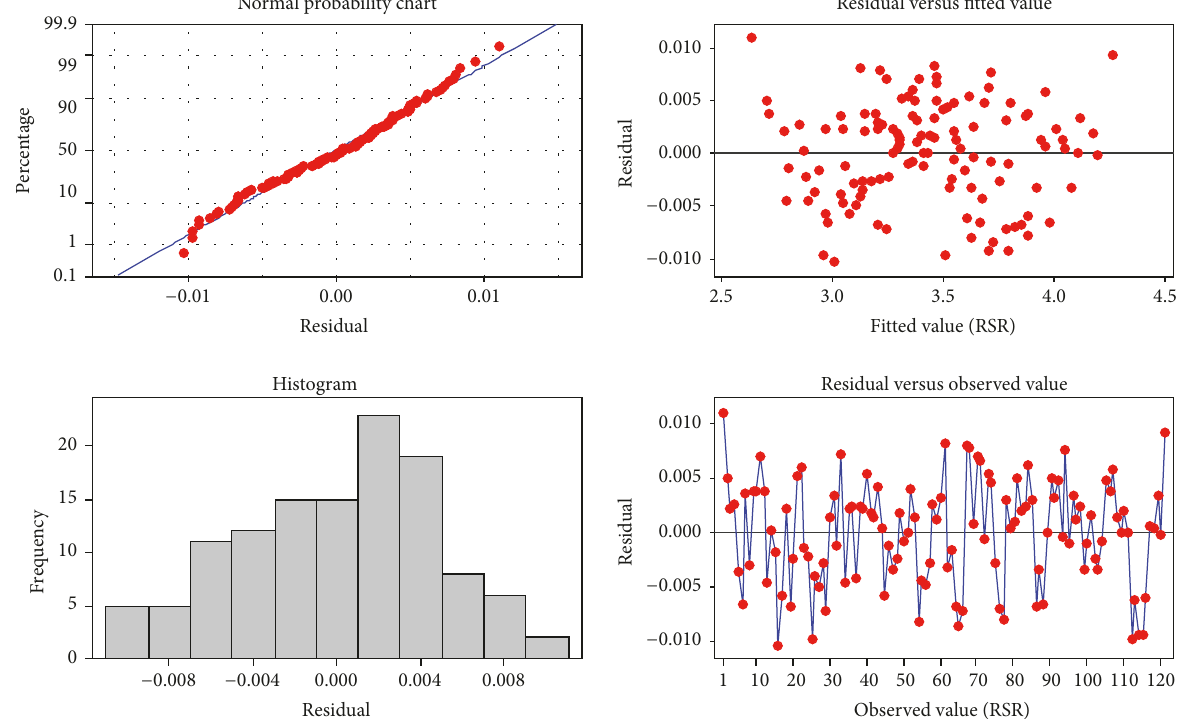
Figure 14: Residual plots for the adequacy check of the quadratic polynomial function.